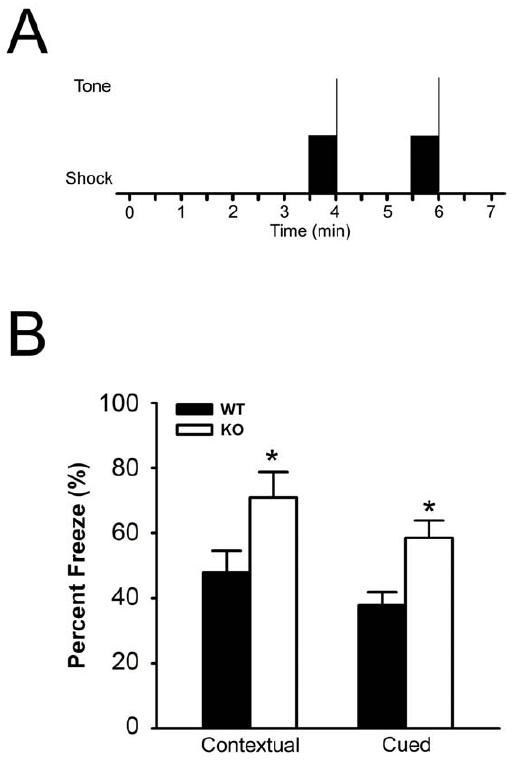
Figure 5. Freezing behavior in fear conditioning experiment. ( A ) Btbd9 mutant mice and WT mice were conditioned to two 30- second tones followed by an electric shock, with a shock interval of 120 seconds. Solid black rectangle represents the period of tone. The vertical line at represents the period of the shock. ( B ) Btbd9 mutant mice had increased percentage of freezing behavior in both contextual and cued fear conditioning, suggesting that the Btbd9 mutant mice had enhanced fear memory. Vertical bars represent means 6 SEM. * p , 0.05.